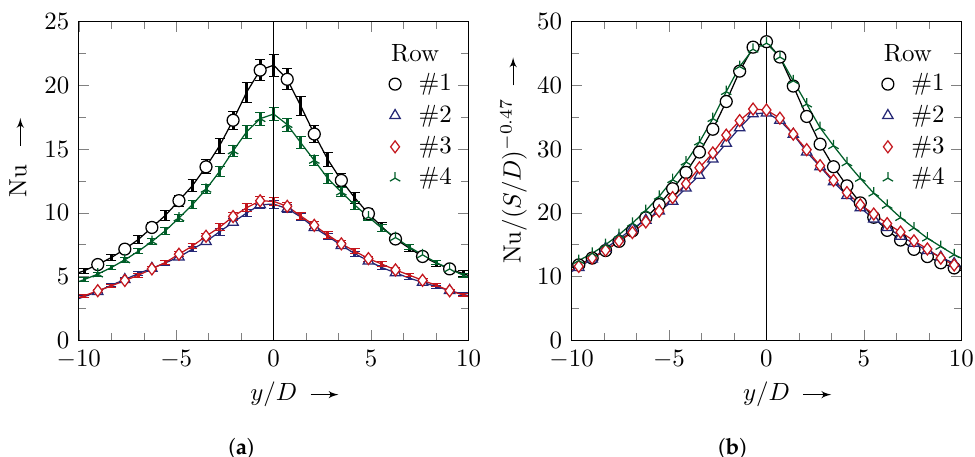
Figure 9. Comparison of the Nusselt numbers for the four rows of impinging jets for Re = 4000: ( a ) Line-averaged Nusselt number; ( b ) Influence of jet-to-jet distance on Nu.